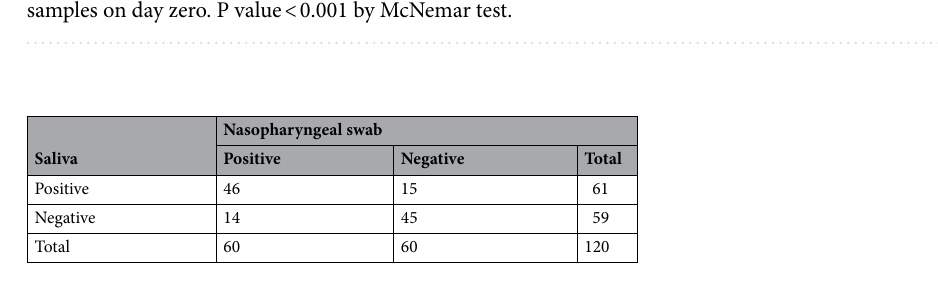
Table 2. Comparison of Real-Time RT-PCR results of paired (n = 60) Nasopharyngeal swab and saliva samples on day eight. P value = 1 and odds ratio 1.07 by McNemar test.